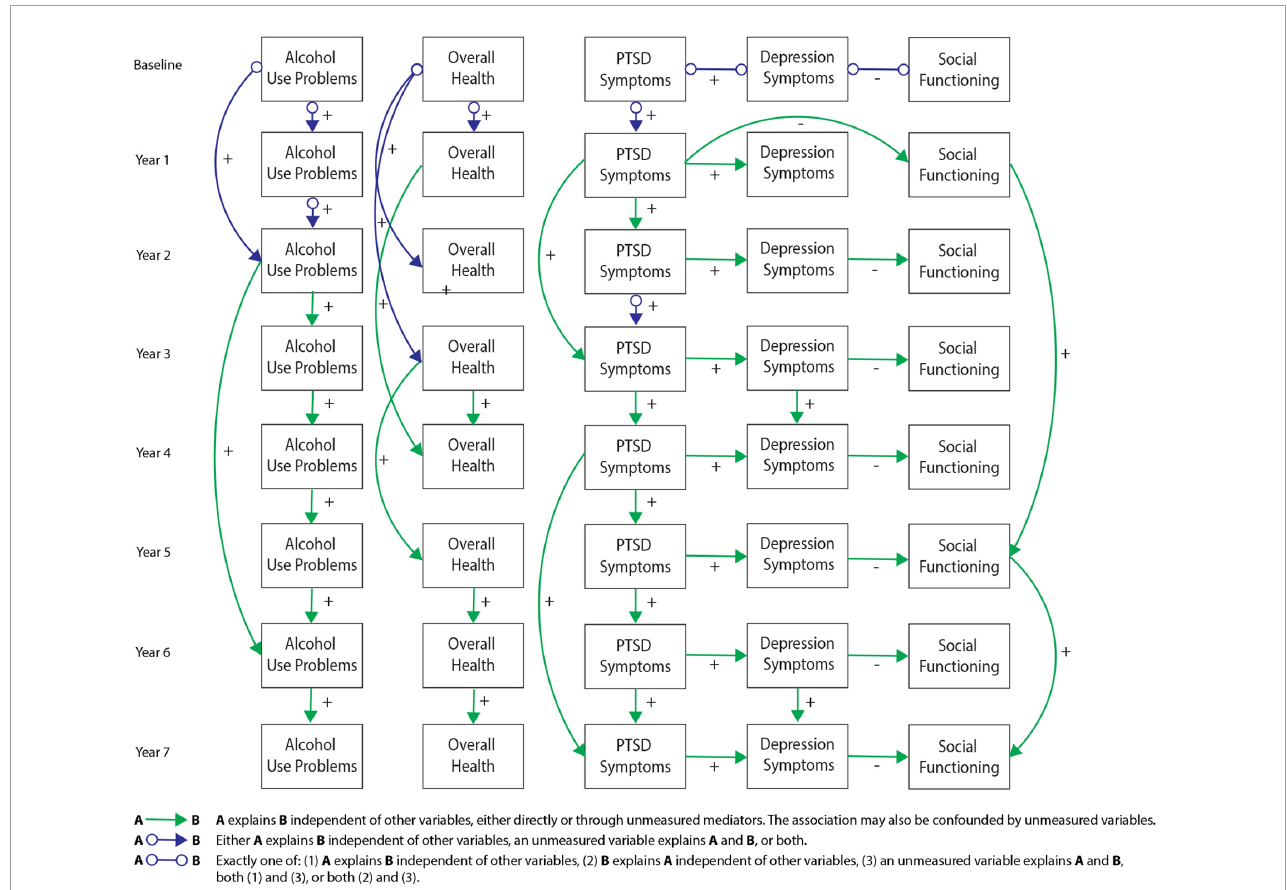
FIGURE2 Greedy Fast Causal Inference (GFCI) graph for the Mind Your Heart study (MYH) sample ( n = 241). Causal links between post-traumatic stress disorder (PTSD) symptoms and depression over the course of 8 years in the MYH sample, leading to social functioning, which are all independent of overall health and alcohol use problems. Colored arrows indicate the level and directionality of the causal edges, with + or – along the edges indicating whether these links cause increases or decreases in scores on the connected